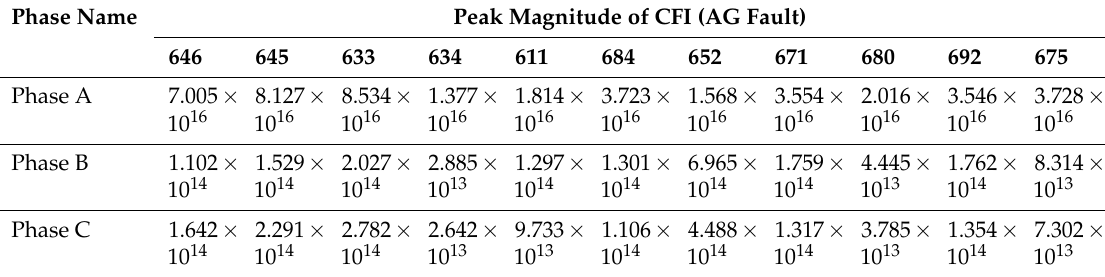
Table 3. Performance of Fault Recognition Algorithm with AG Fault at Different Nodes of the Test System.